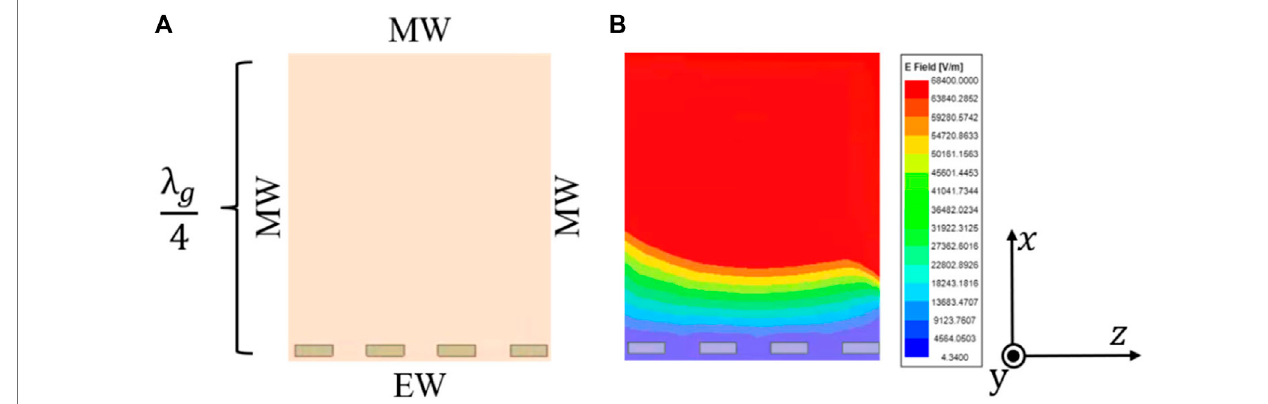
FIGURE 4 | S 21 of the HMSIW BPF with (A) varied L s at W s (cid:3) 450 μ m and (B) varied W s at L s (cid:3) 8 μ m